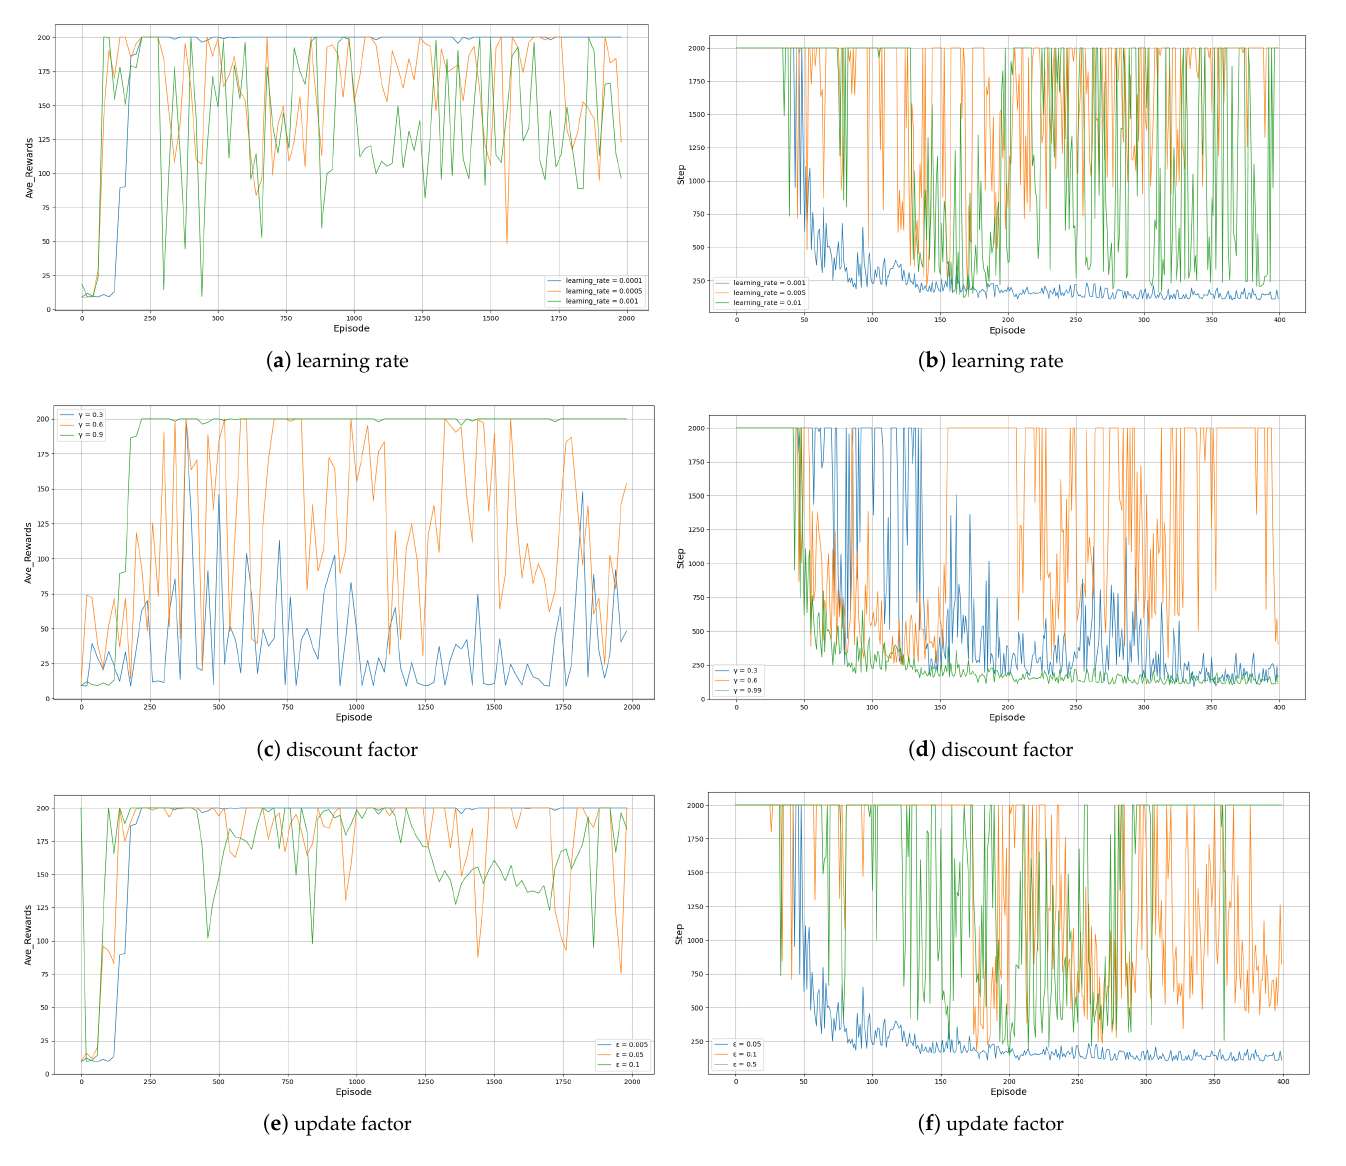
Figure 3. In Two Environments, The Impact Of Different Parameters On IPD3QN.